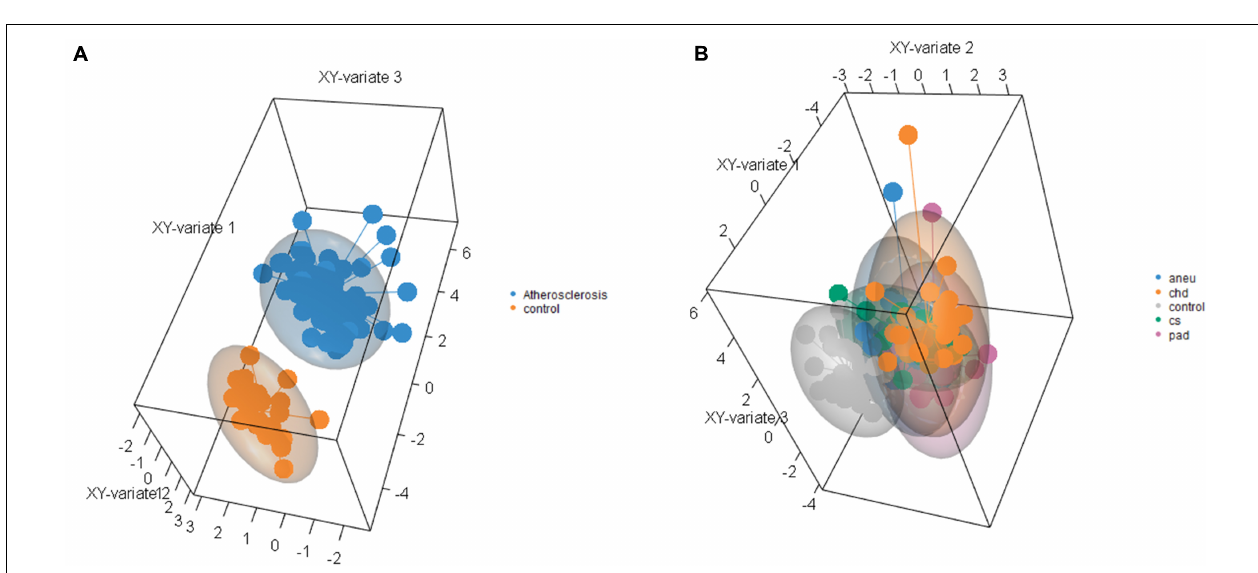
FIGURE 5 | Unsupervised clustering results: (A) is the principal component analysis (PCA) result of the comparison of the athero and control group. (B) is showing the results of the subgroups and control comparison. Dataset was reduced to the 500 most variant miRNAs; PC1 = principal component 1; PC2 = principal component 2; aneu = abdominal aneurysm; chd = coronary heart disease; cs = carotid stenosis; pad = peripheral artery disease.